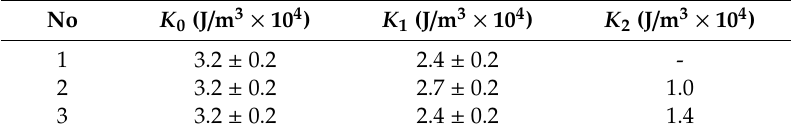
Table 2. Anisotropy constants used in numerical simulations of the nanostructured